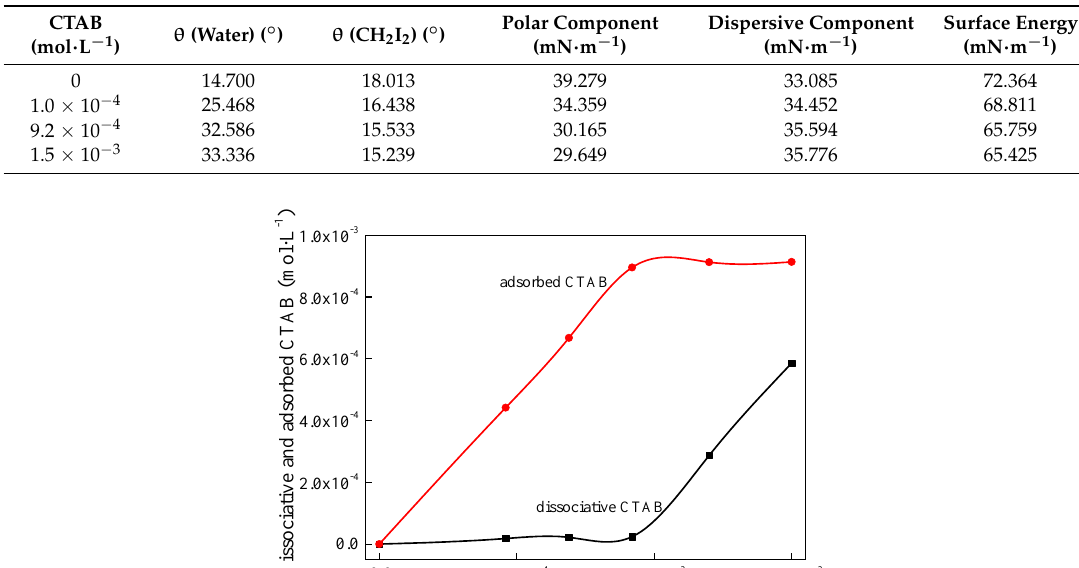
Table 1. Surface energy and polar and dispersive components of α -CaSO 4 · 0.5H 2 O whiskers.